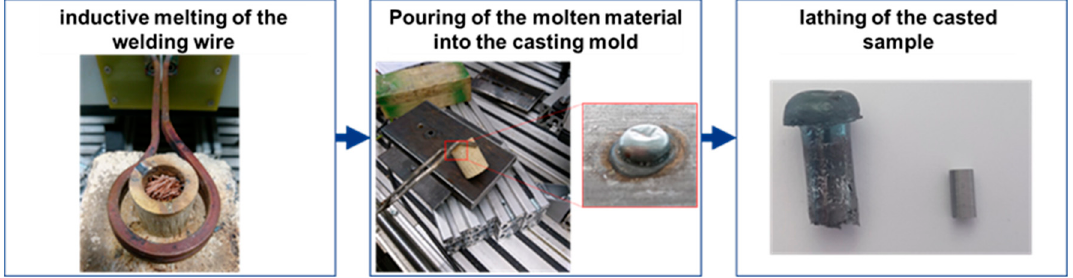
Figure 11. Procedure of the casting process for producing cylindrical specimens.